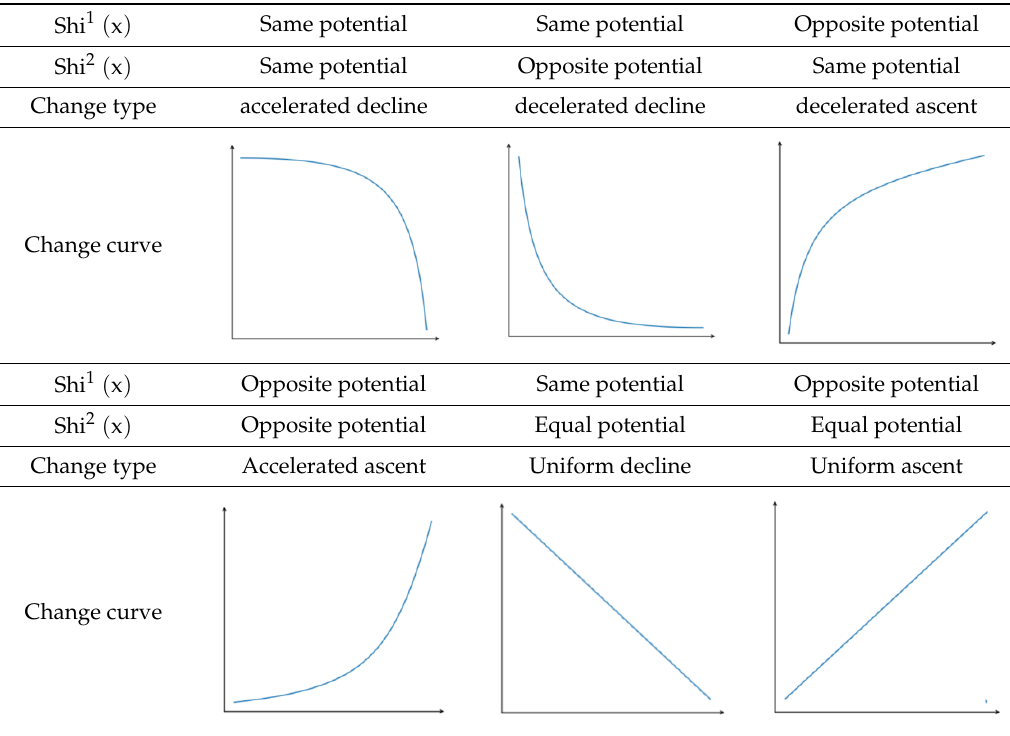
Table A3. Trend curve of the risk.